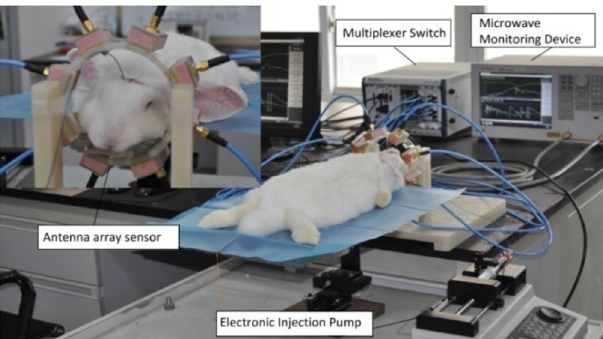
Figure 1. Experimental setups for monitoring cerebral hemorrhage in rabbits with the multichannel microwave-based stroke detection system.